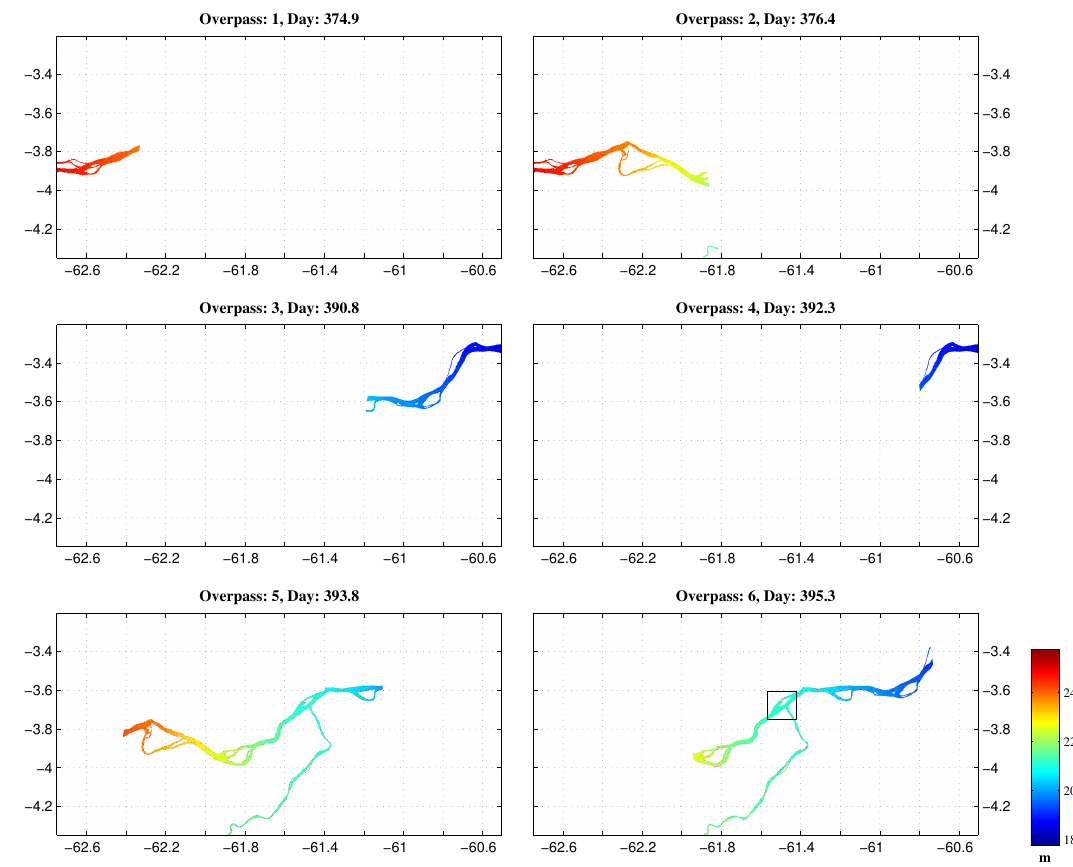
Figure 6. SWOT water elevation measurements derived from hydraulic model output (Figs. 4 and 5) and science requirements (Fig. 3) for cycle 18 (at high water), for each of the six overpasses during the 22-day cycle. The box shown in overpass 6 indicates the area shown in detail in Fig. 7.